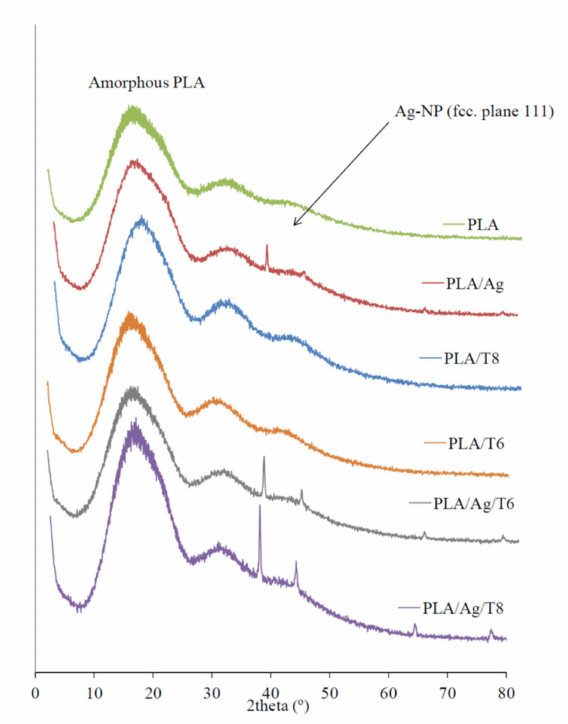
Figure 2. X-ray di ff raction (XRD) patterns of PLA and active nanocomposite